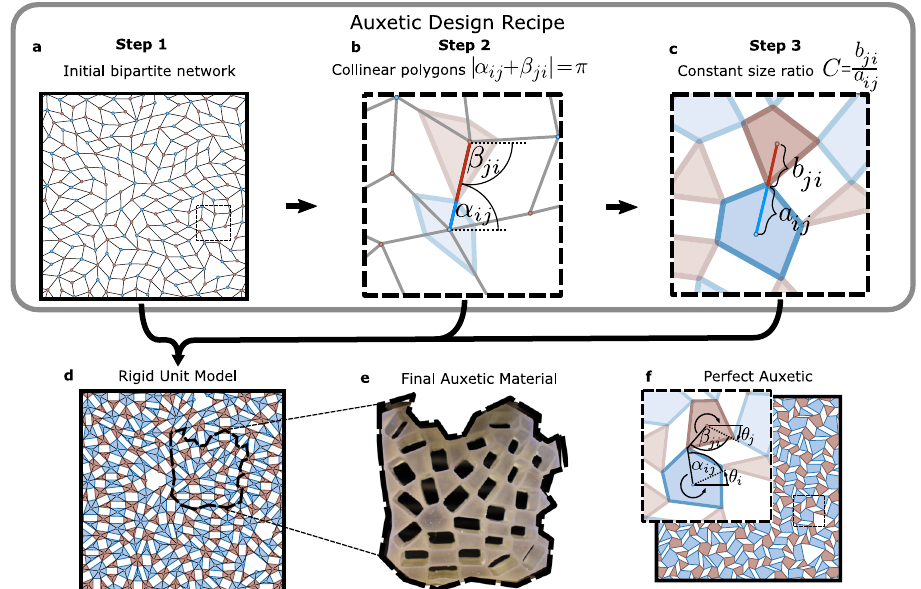
Fig. 2 The 3 steps recipe. a Step 1, we start with a bipartite network, the blue and red colours stand for the A and B sets respectively. We showcase a random bipartite network to demonstrate the versatility of this recipe. b Step 2, every node of the graph becomes the position of each polygon and we place each polygon ’ s vertex on top of each corresponding segment of the network. At rest the polygon ’ s position is collinear with its neighbour ’ s position and the vertex between them. c Step 3, each polygon vertex is positioned such that the ratio C = b ji / a ij remains constant along the network. a ij is the distance from the node to each vertex in the A set polygons, b ji is the analogue for the B set. d The resulting polygon network after performing the 3 steps. e A section of the fi nal random auxetic design printed in 3D. As every section of the model is inherently a perfect auxetic, the printed material keeps being auxetic. f A compression shows that the polygon network is a perfect auxetic. In the zoom in we see how each polygon counter rotates with respect to its neighbours. θ i and θ j show the rotation of the A and B set